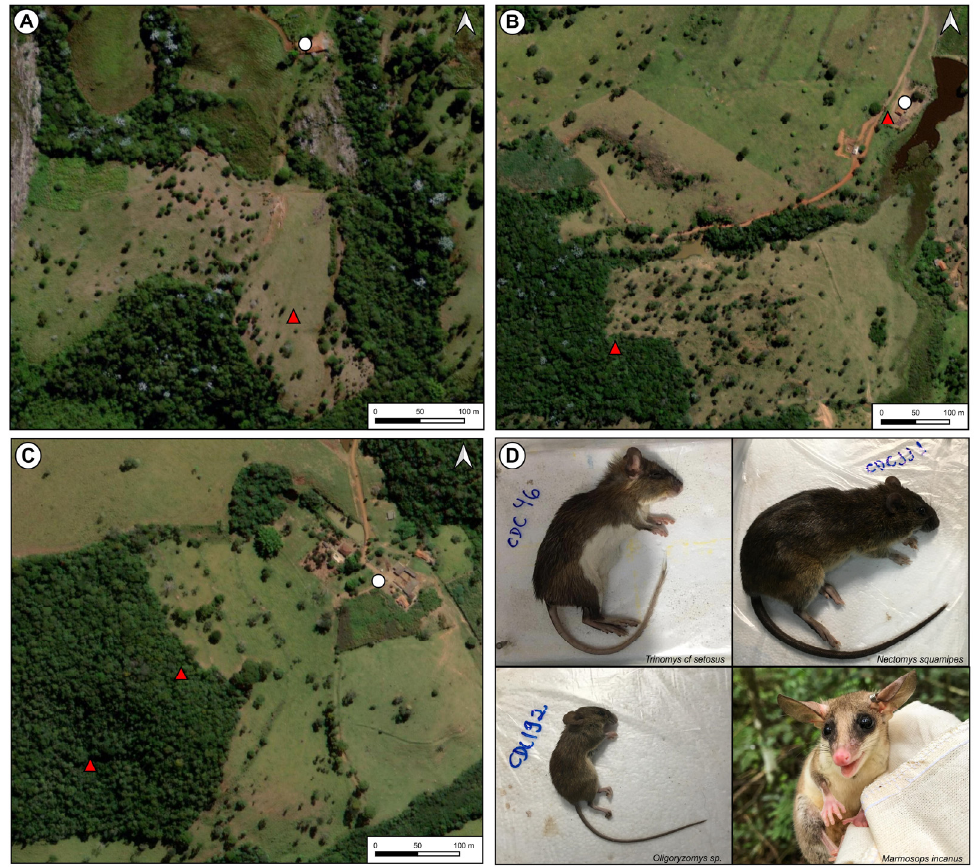
Figure 2. Capture location of seropositive species, Brazil, 2021. The ( A – C ) farm buildings are indicated by white circles and spots of seropositive animal capture by red triangles. Trinomys cf setosus, Nectomys squamipes, and Oligoryzomys sp. in panel ( D ) were photographed after anesthesia administration. Marmosops incanus in panel ( D ) was photographed after its capture in the fi eld.